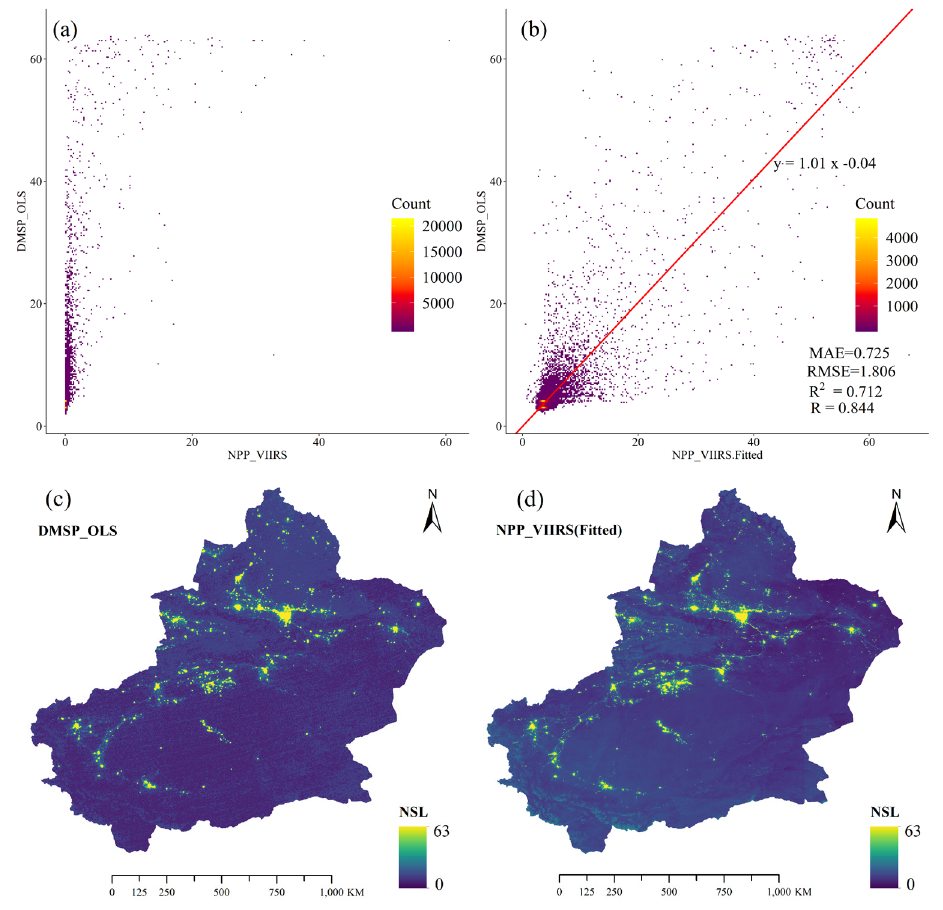
Figure 10. The relationship between DMSP_OLS NSL and before and after NPP_VIIRS NSL fitted in 2013 ( a , b ), and the spatial distribution of DMSP_OLS NSL ( c ) and NPP_VIIRS NSL fitted in 2013 ( d ).